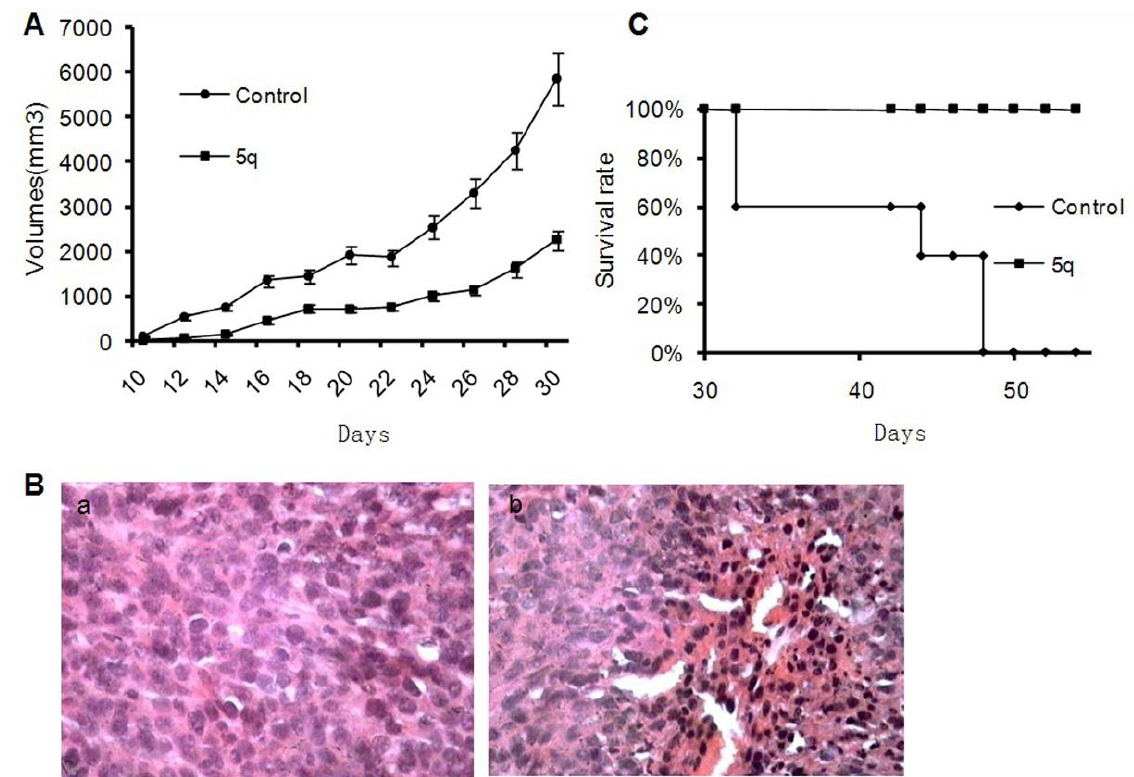
Figure 1. Effects of 5q on tumor-bearing mice. 5q was orally administered to Balb/c mice through gastric perfusion daily at a dosage of 75 mg/kg about 10 days after inoculation of cells. The volume of tumor was calculated by the following formula: volume (mm 3 ) = long diameter (mm) × short diameter (mm) 2 × 0.5236. ( A ) Oral treatment with 5q presents a decrease in tumor volume against untreated ( p < 0.05). ( B ) H&E staining of tumor tissue sections of untreated group ( a ), 5q -treated group ( b ) (400 × ). ( C ) Oral treatment with 5q presents a survival advantage against untreated. Data are plotted as the percentage of survival animal.